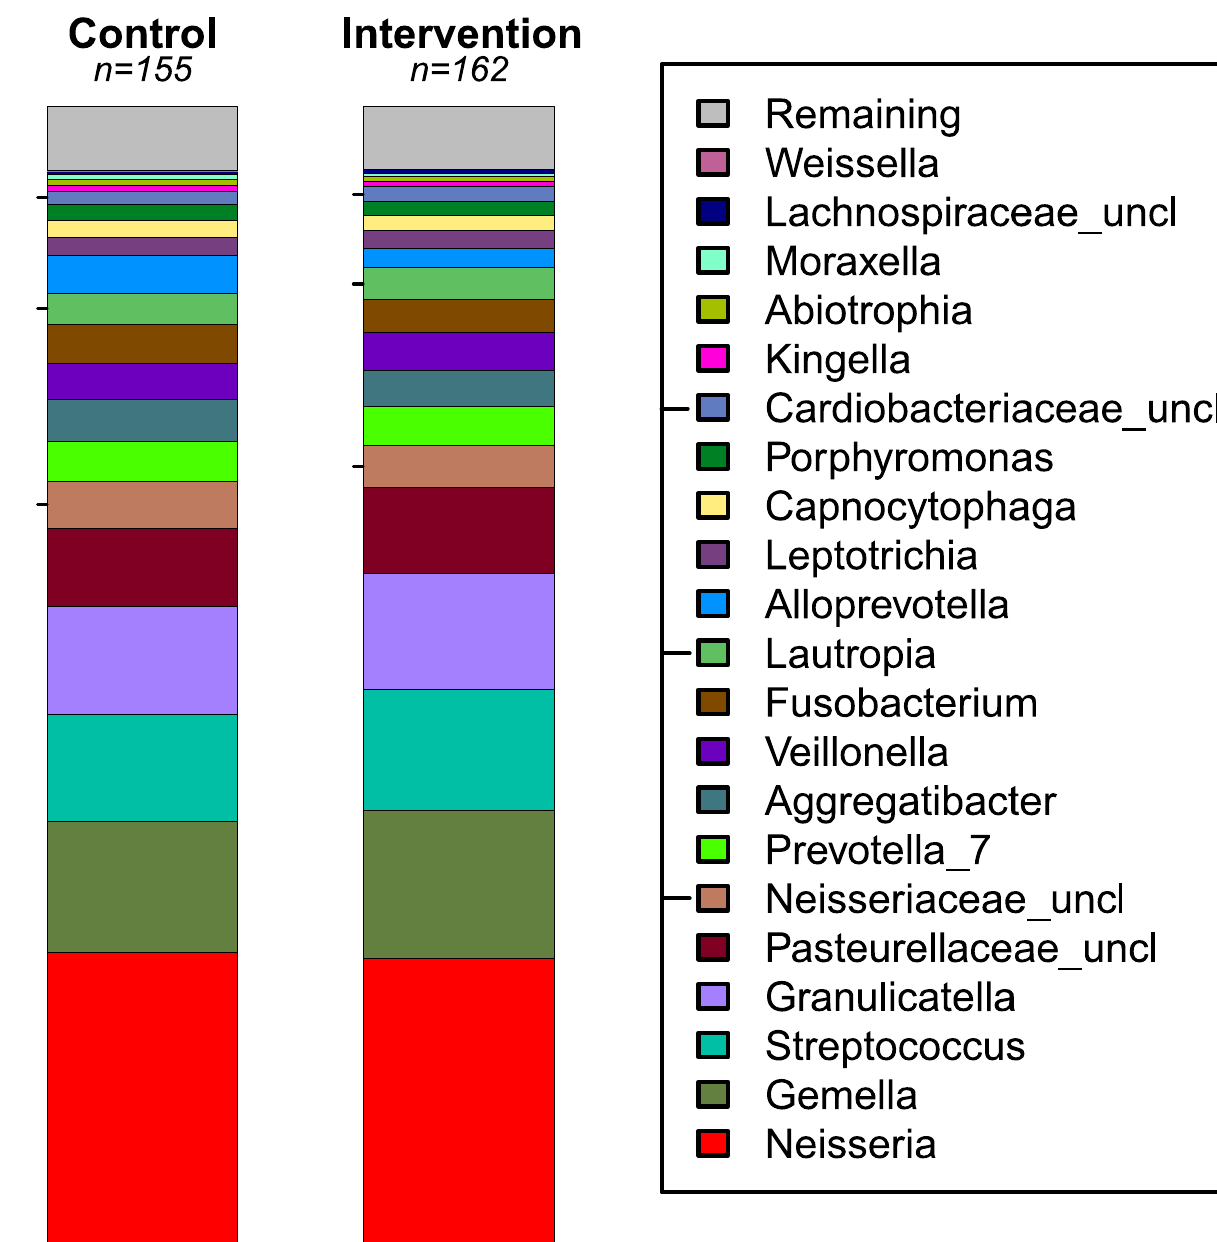
Figure 4. Stacked bar plot comparing control and intervention. The left and right stacked bar plots illustrate the average taxonomic composition of the control (155 subjects) and intervention (162 subjects) groups, respectively. The most and least abundant taxa are depicted at the bottom ( Neisseria ) and at the top ( Weissella ), respectively. The “Remaining” category is a placeholder for all the remaining taxa with abundances too low to represent. Tick marks placed on the left margin of the legend are also located by their corresponding position in the stacked bar plot. “Uncl” labeled taxa are reads not classifiable with confidence to the genus